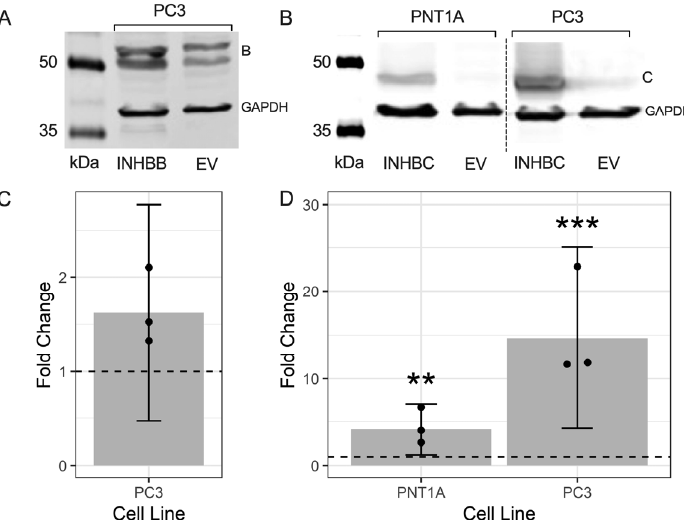
Figure 5. Representative Western blots showing the overexpression of ( A ) INHBB in transfected PC3 cells and ( B ) INHBC in transfected PNT1A and PC3 cell lines. Graphs show fold-change of the fluorescent intensity relative to the EV control cells (dashed line at 1.0) for ( C ) INHBB and ( D ) INHBC. Data presented as individual fold-change values (dots) and the emmean fold-change ± 95% confidence limits (grey bar and lines) from 3 Western blots. ** p < 0.01 and *** p < 0.001 analysed by a NLM.